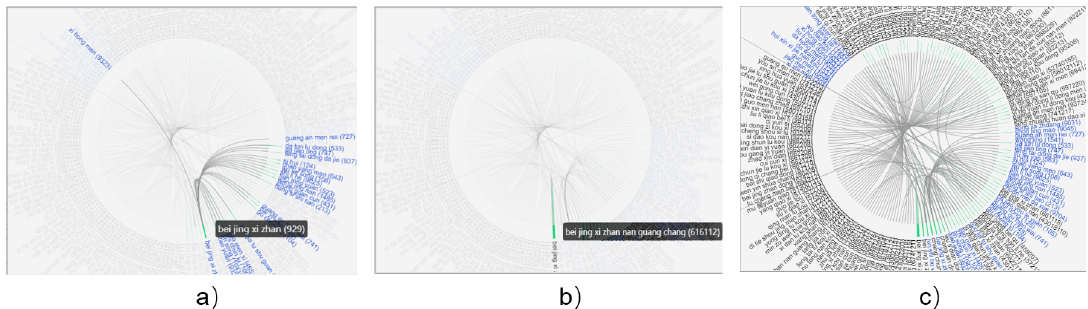
Figure 18. Passenger origin-destination chord view ( a ) Card number 13080401, ( b ) Card number 13080401, ( c ) Card number